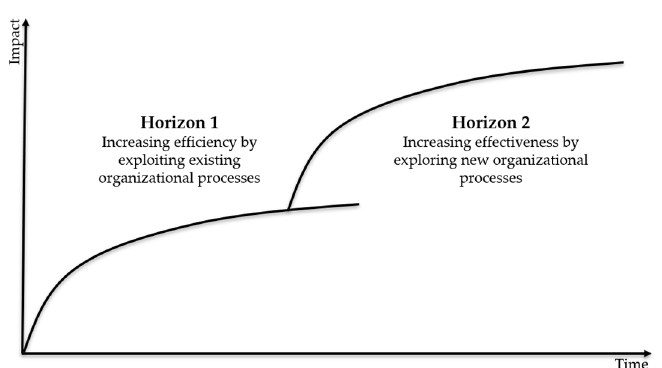
Figure 1. Managerial horizon model.